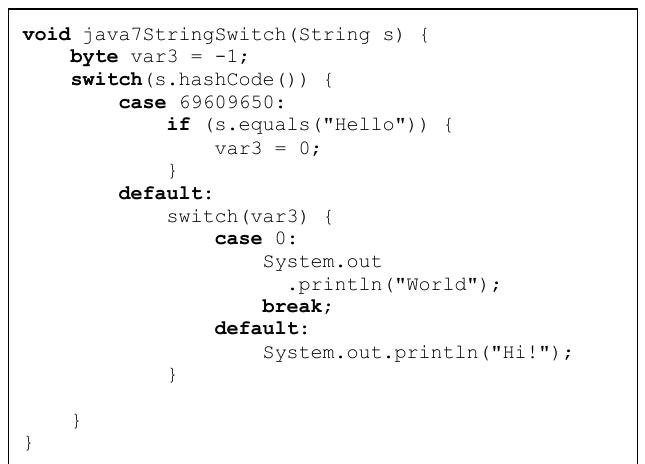
Fig. 19. String literal in switch statement decompiled by